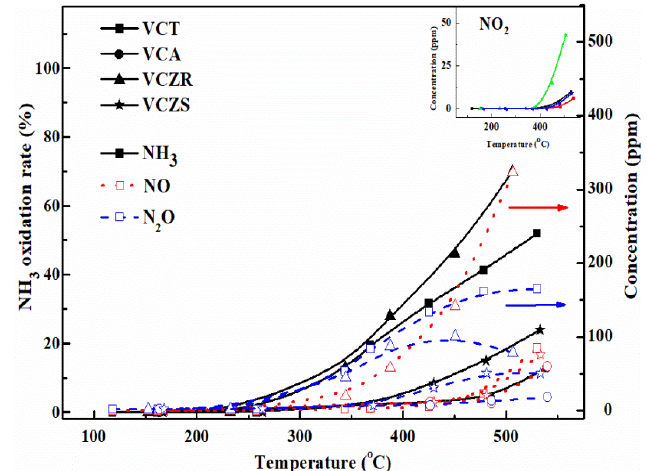
Figure 10. NH 3 oxidation and concentration profile of NO, N 2 O over different samples (reaction conditions: NH 3 = 700 ppm, O 2 = 3%, balance N 2 , 0.5 g catalyst, and GHSV about 50,000 h −1 ).